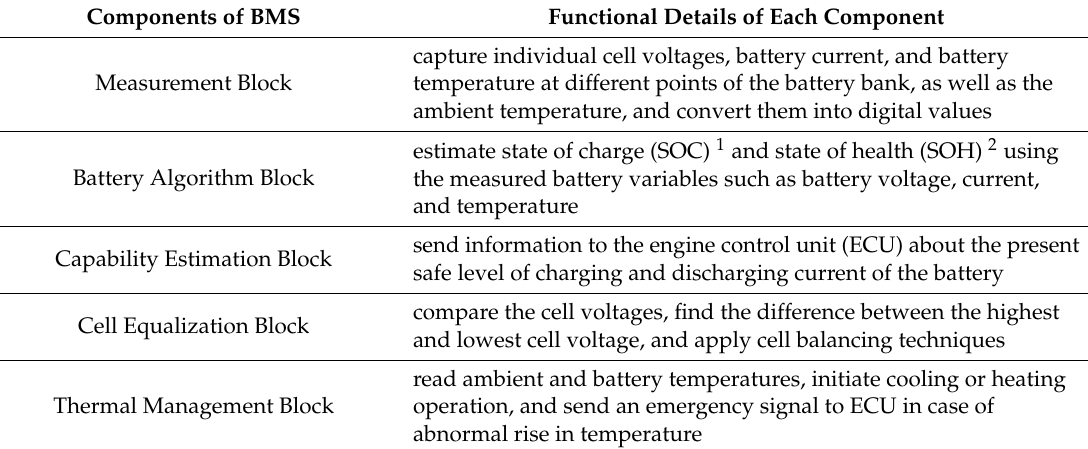
Table 2. Components of BMS and their roles